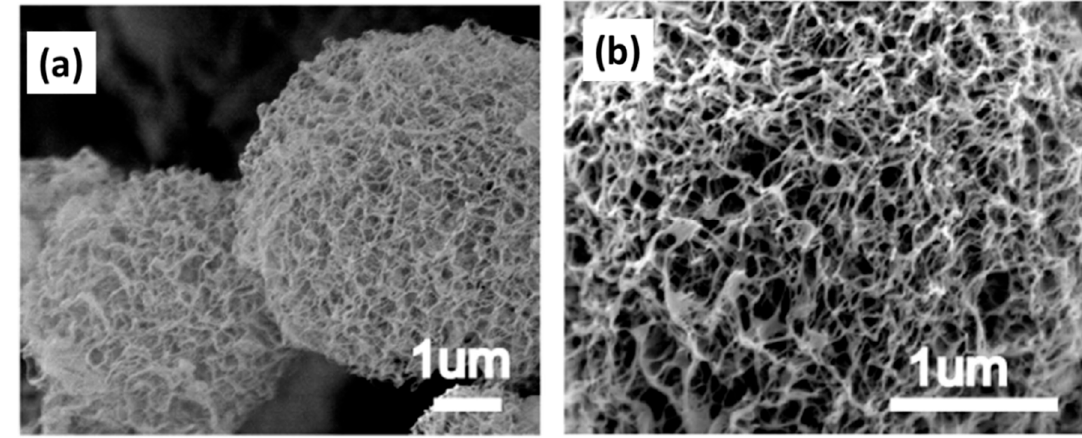
Figure 12. SEM images of TEMPO oxidized cellulose nanofibril-based aerogel microspheres ( a ) prepared by freeze drying method and the particles morphology under the higher magnification ( b ); reproduced with permission from reference [95].